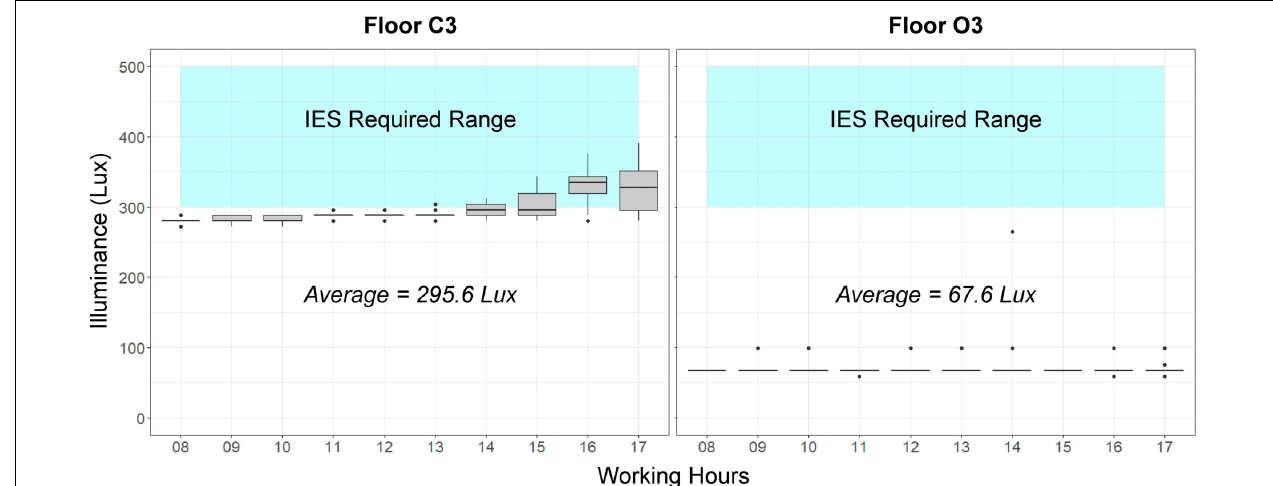
FIGURE 5 | Post-retrofit light intensity on C3 and O3 during working hours on